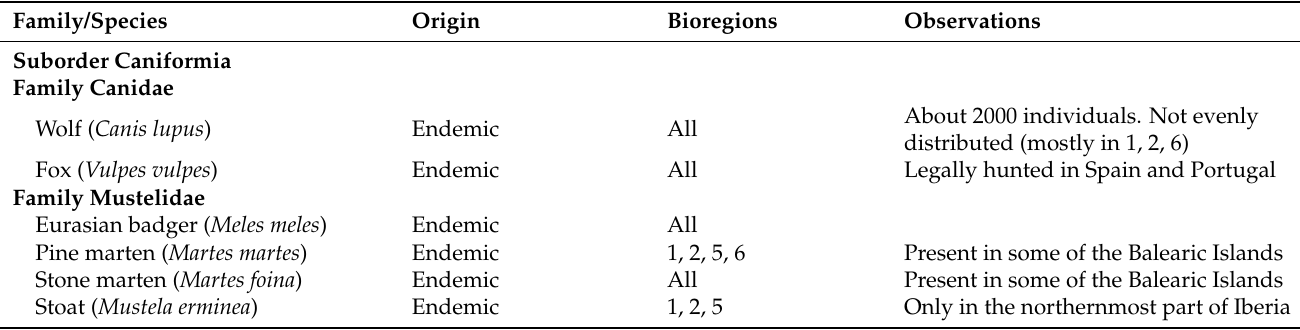
Table 1. Iberian carnivores. Distribution refers to the bioregions displayed in Figure